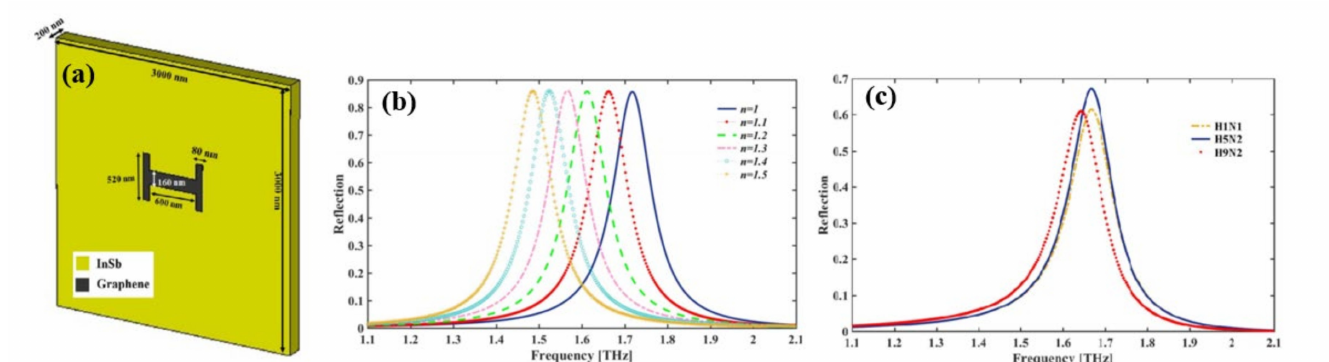
Figure 9. ( a ) Schematic illustration of the unit cell, ( b ) simulated reflection spectrum of biosensor in different mediums metamaterial reflector and ( c ) simulated results of reflectance spectra for different AI virus vs. frequency. Reprinted with permission from [65]. Copyright 2019